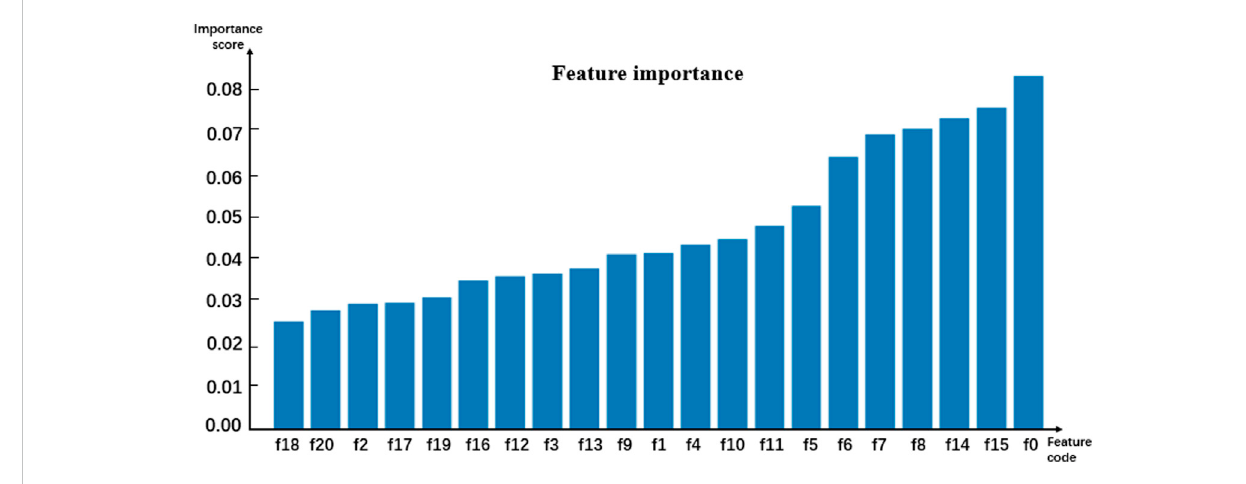
FIGURE 2 Histogram showing the importance of parameters in model M1.